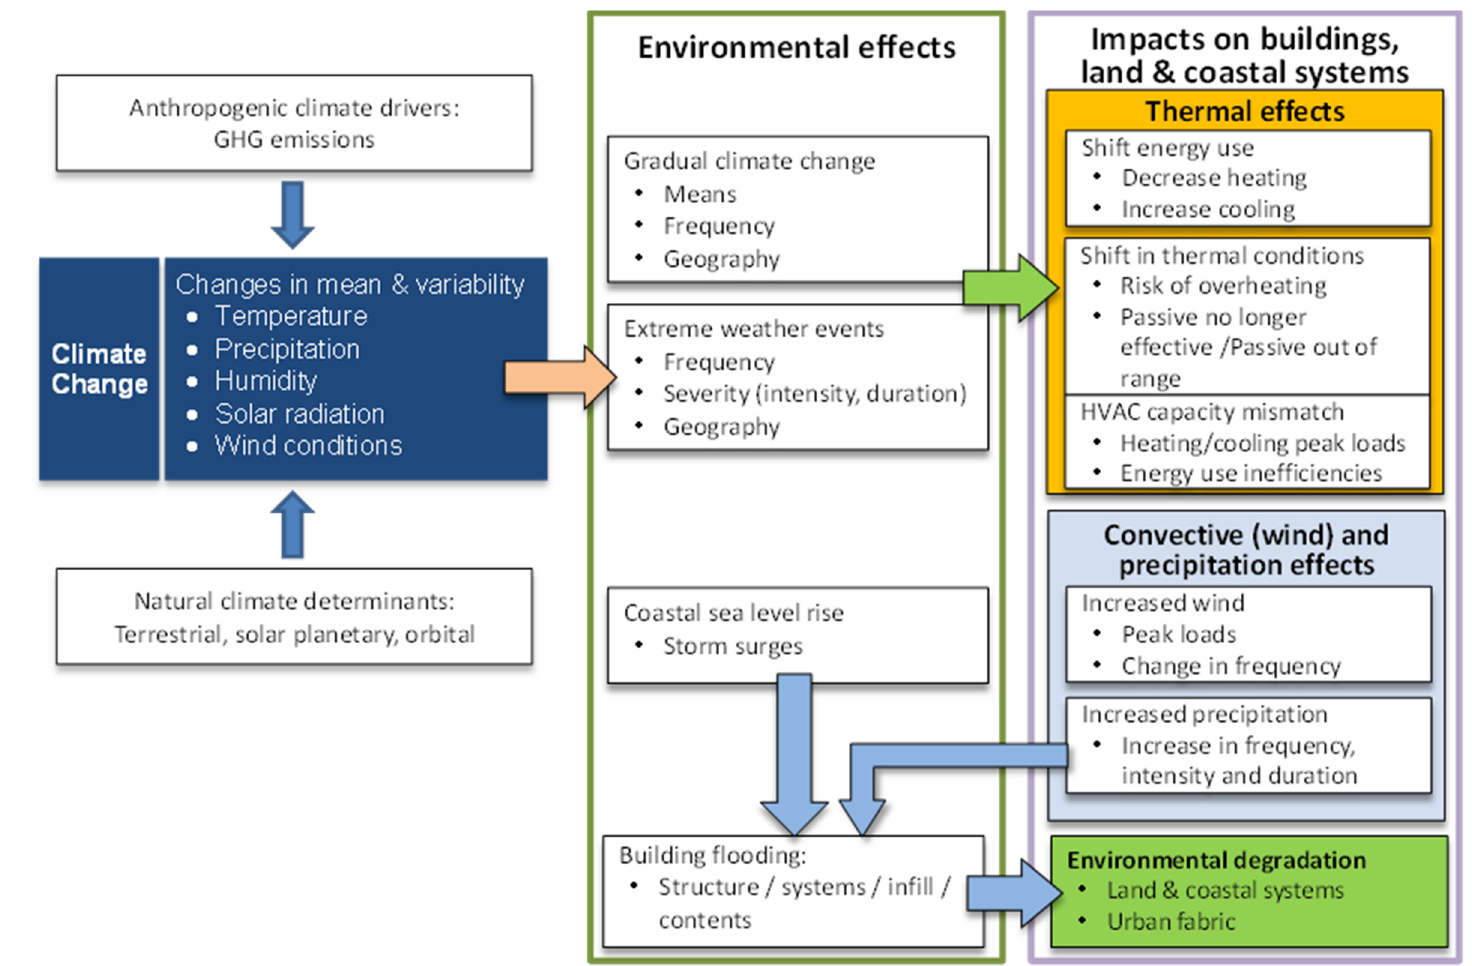
Figure 4. Climate change and impacts on buildings; adapted from [3].